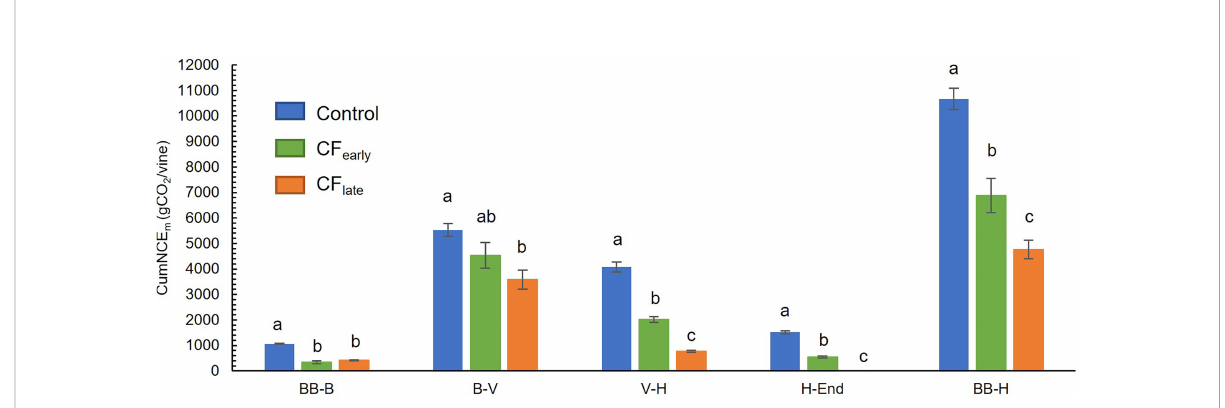
FIGURE 5 Cumulative net carbon exchange (CumNCE m ) between two different phenological stages in 2019. Forced treatments included only post-forcing data. BB, bud burst; B, bloom; FP, forcing pruning; V, Veraison; H, harvest; End, end of season. Blue, green, and orange correspond to Control, CF early and CF late treatments, respectively. Each column indicates the mean of four vines. Bars indicate standard deviation. Treatment effects were analysed using ANOVA and the means were separated with the Tukey test. Means followed by different letters are signi fi cantly different at P <